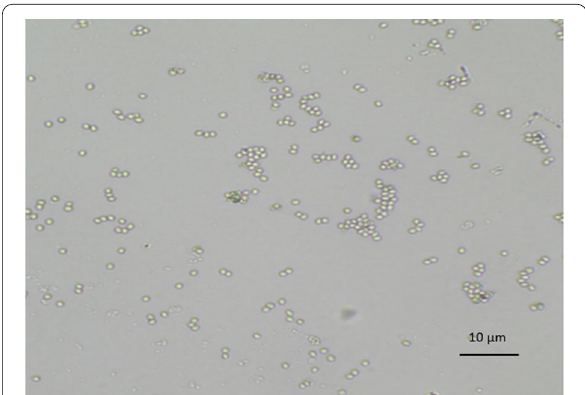
Fig. 3 Hyaline, single celled, globose conidia of MZ749636 ( B.b